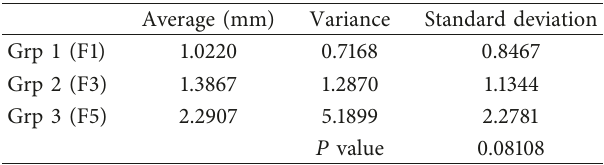
Table 1: Calculation of the average, variance, and standard de- viation of the dye penetration depths in the 3 experimental